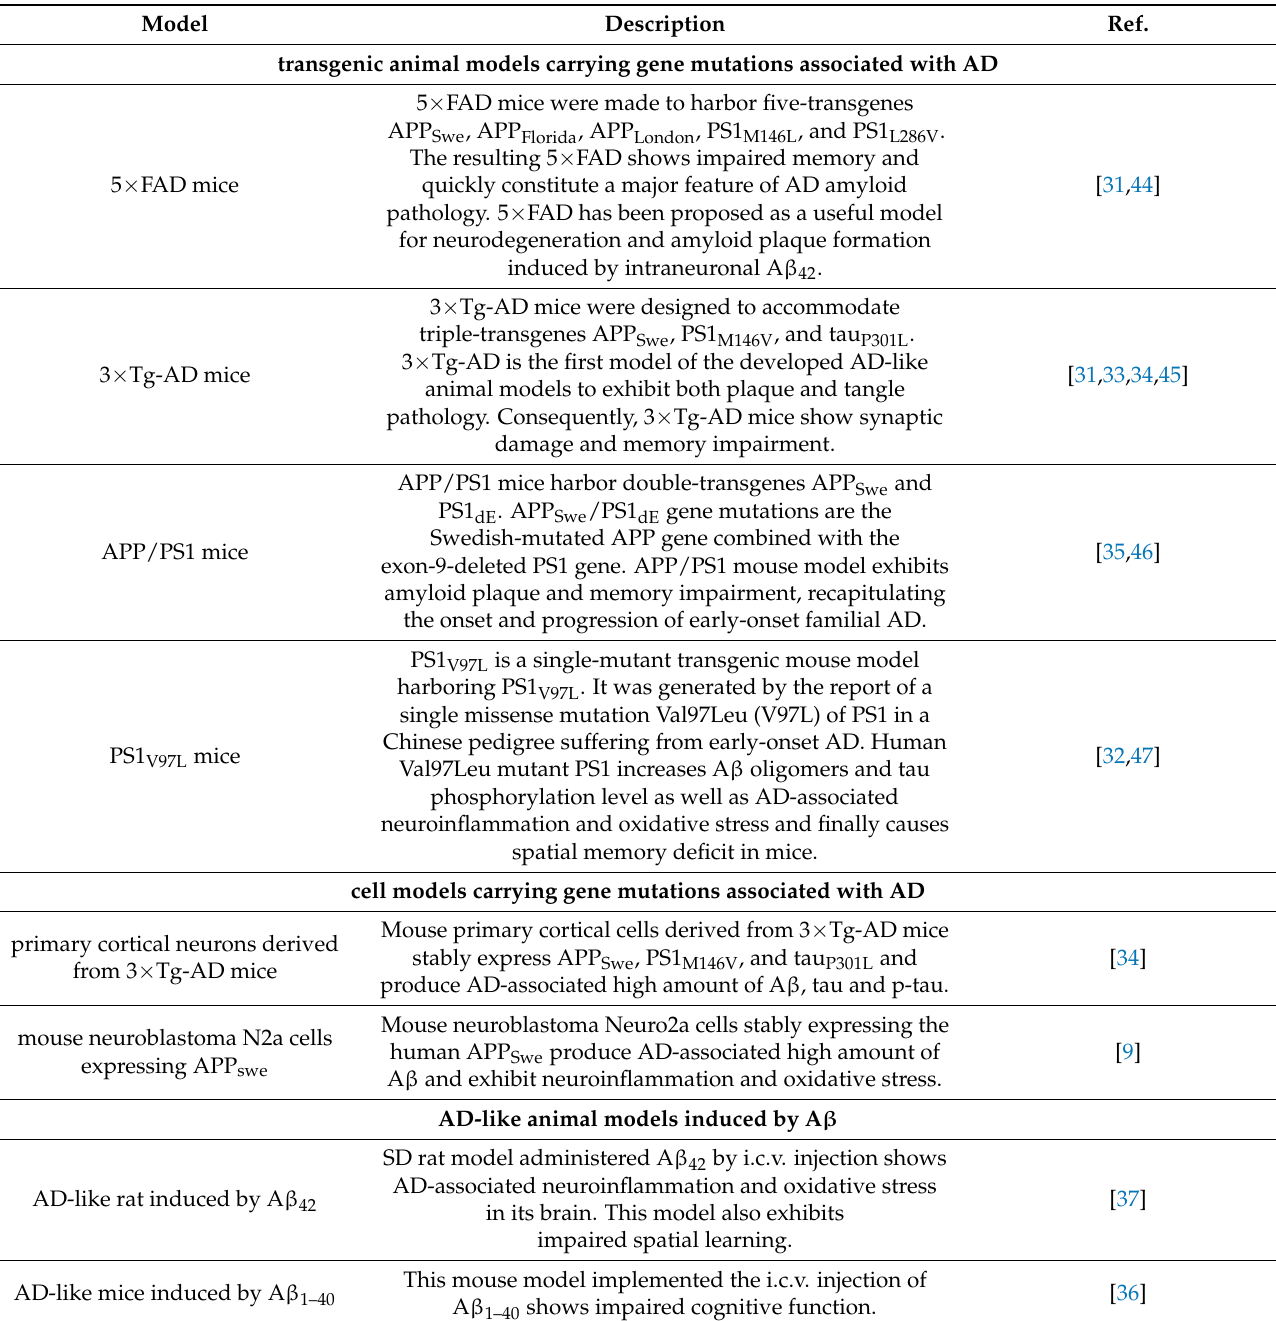
Table 1. Alzheimer’s disease (AD)-like animal and cell models cited in this review to examine the AD neuroprotective potential of